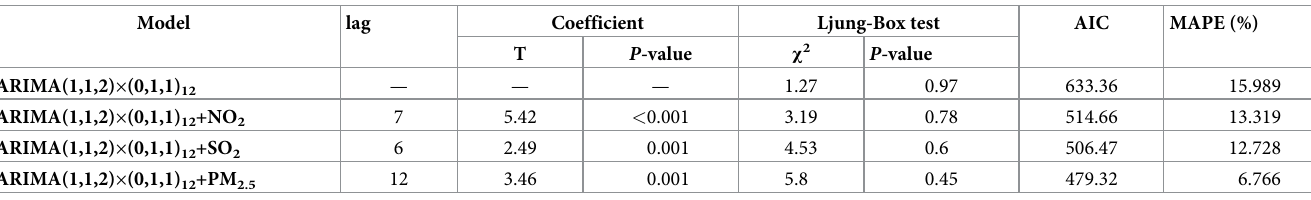
MAPE values. It was found that RNN5 model had the smallest MAPE value (see Table 7), which implied RNN5 model was the optimal one. Apart from CO, other air pollutants in Table 6. The residual and parameter tests of ARIMAX